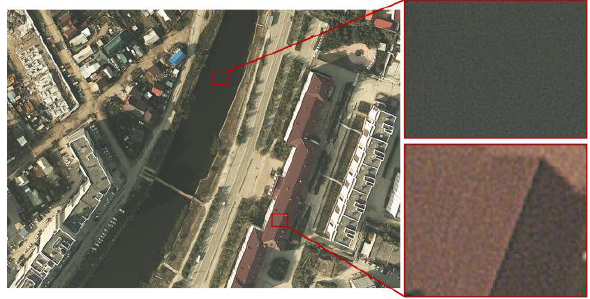
Figure 11. The decrease in information and interpretation quality of an aerial image due to deep shadows and a high random noise Figure 13. An example of color disbalance in aerial image: false Methods of random image noise assessment: colors for individual objects (left) and the predominance of a visually, at large magnification of flat uniform color tone throughout the image (right) surfaces (water, flat roofs), areas of shadows from high-rise objects (multi-storey buildings, etc.), as shown in Figure 12, Methods of color balance assessment: numerically, by calculating the root-mean-square manually by comparing the color components of pixels deviation (RMS) of noise, using specialized software that implement the appropriate algorithms (for example, method of harmonic analysis) (Lapshenkov, 2012; Lapshenkov, 2013; Miao, 2019; Chen, Zhang et al., 2019).